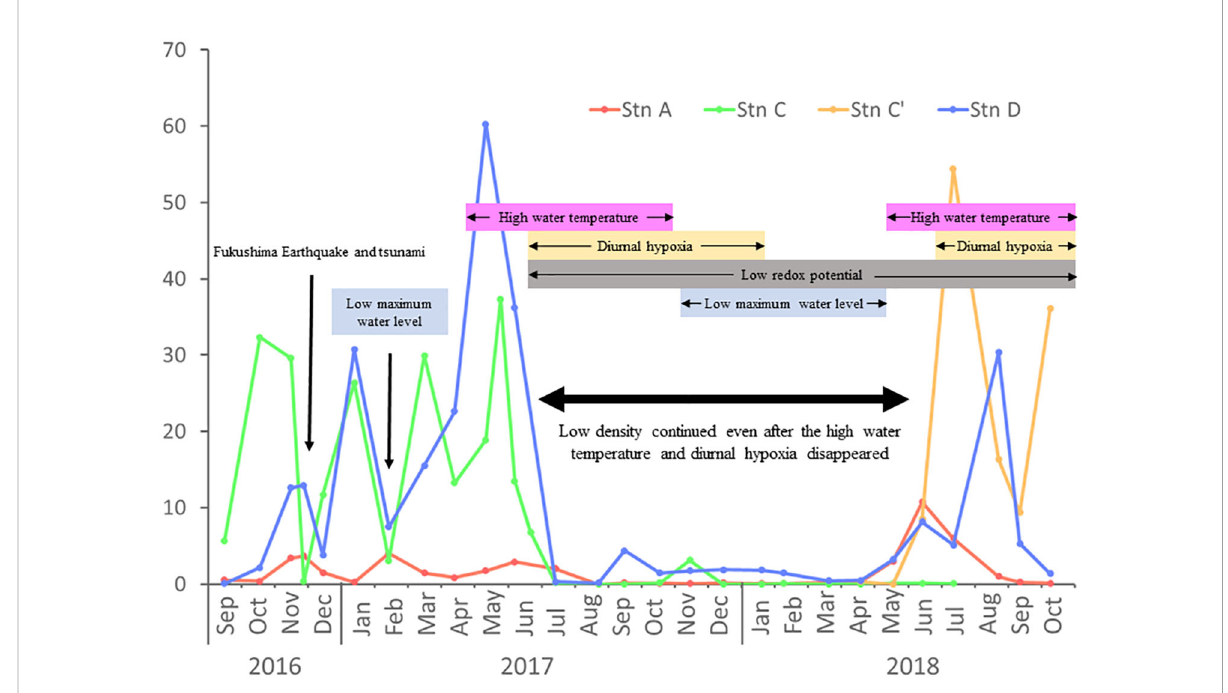
FIGURE 10 Summarizing C. aff. teleta density and environmental factors associated with water stagnation and circulation due to levee construction and channel